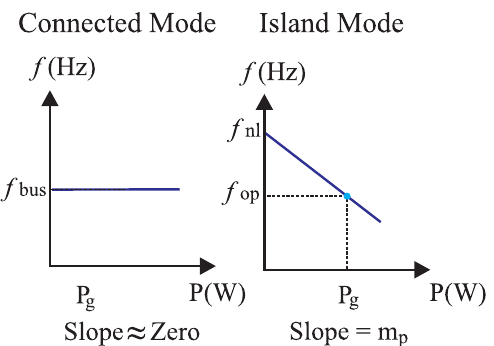
Figure 3. Islanding detection through droop control